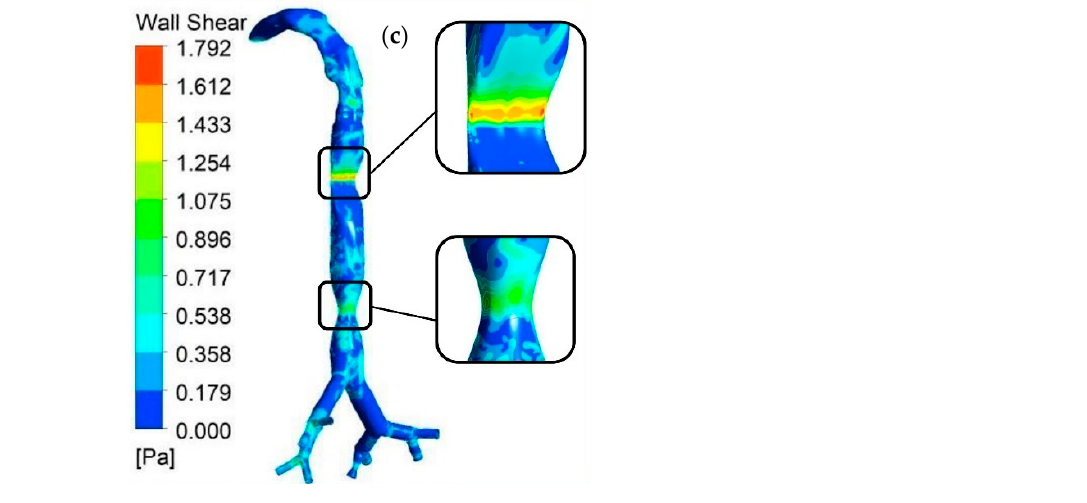
Figure 9. Wall shear on the whole lung model with stenosis sections for different flow rates: ( a ) 7.5 L/min; ( b ) 15 L/min; and ( c ) 25 L/min.